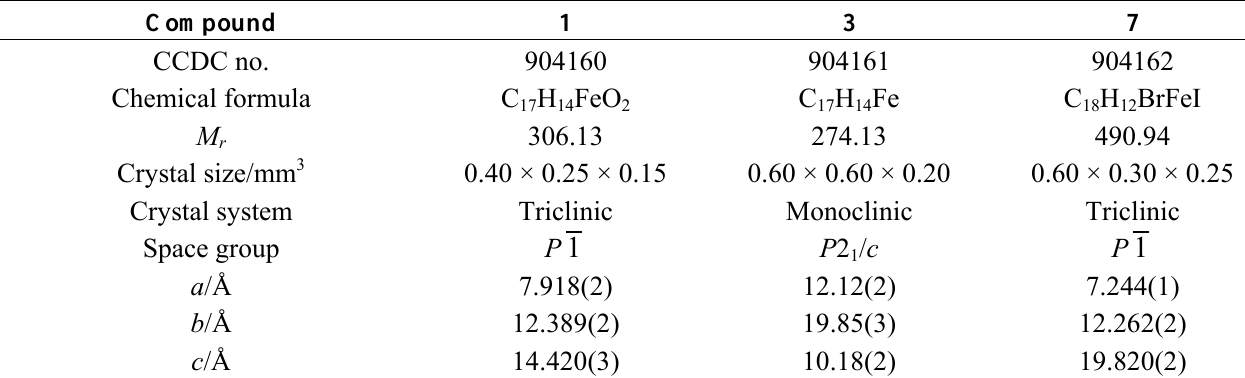
Table 1. Crystal data and structure refinement